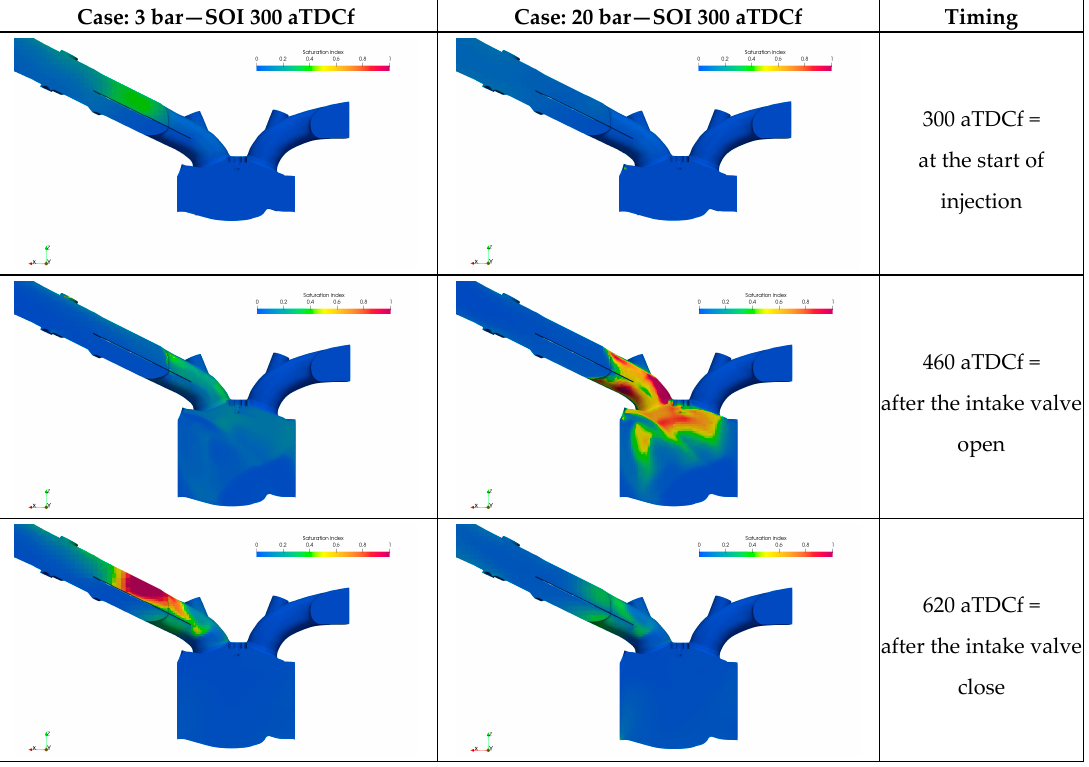
Figure 11. Comparison of saturation index between the case at 3 bar—SOI 300 aTDCf and the case at 20 bar—SOI 200 aTDCf, for three different timings.